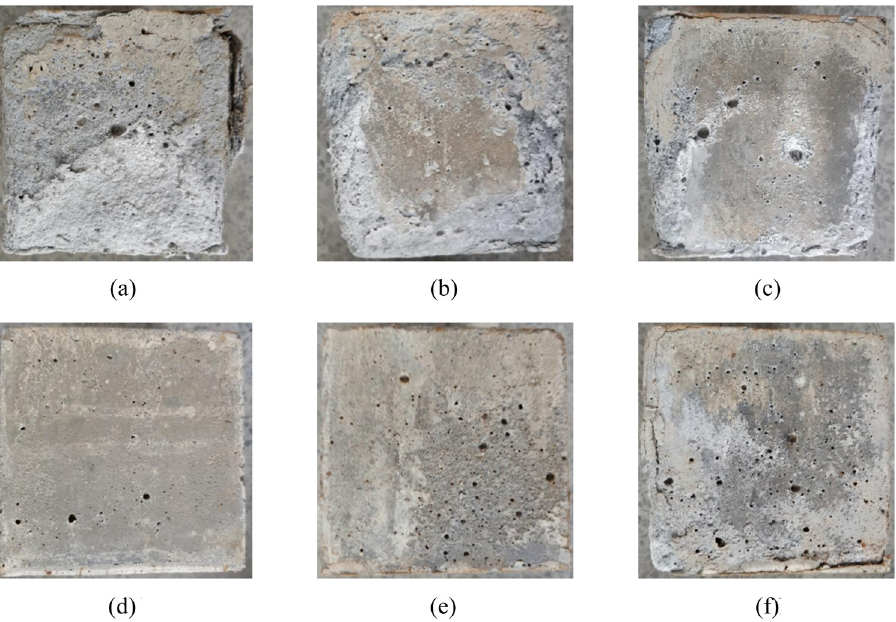
Figure 20: Form of geopolymer mortar destroyed by sulfate erosion in di ff erent content of nano - SiO 2 [ 99 ] . ( a ) NS - 0.0, ( b ) NS - 0.5, ( c ) NS - 1.0, ( d ) NS - 1.5, ( e ) NS - 2.0, and ( f ) NS -